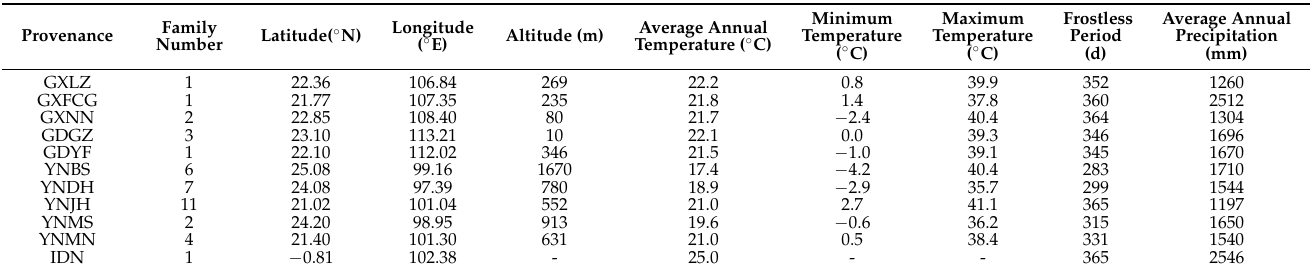
Table 1. Geographical locations of the sampled N. cadamba populations and their climatic properties. Provenance Family